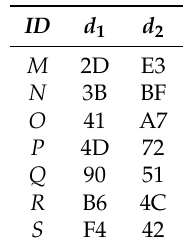
Table 1. Secure skyline objects set, Sky ( DS 1 ) of DataNode 1